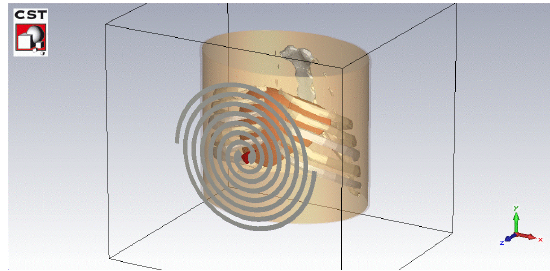
Figure 1: PAS antenna (a) Sketch, (b) Gain pattern